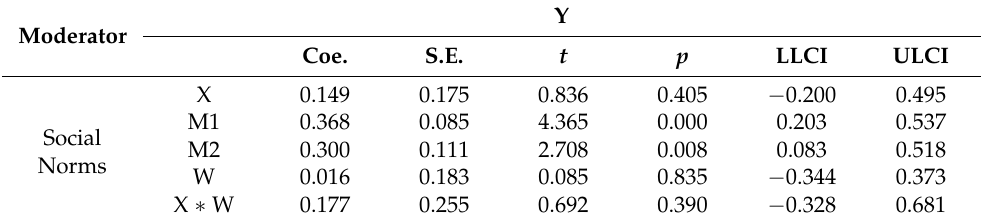
Table 4. The moderating role of social norms (3).